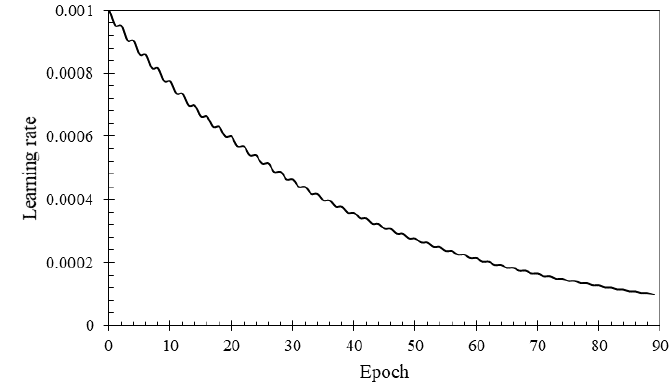
Figure 3. Learning rate decay during training.